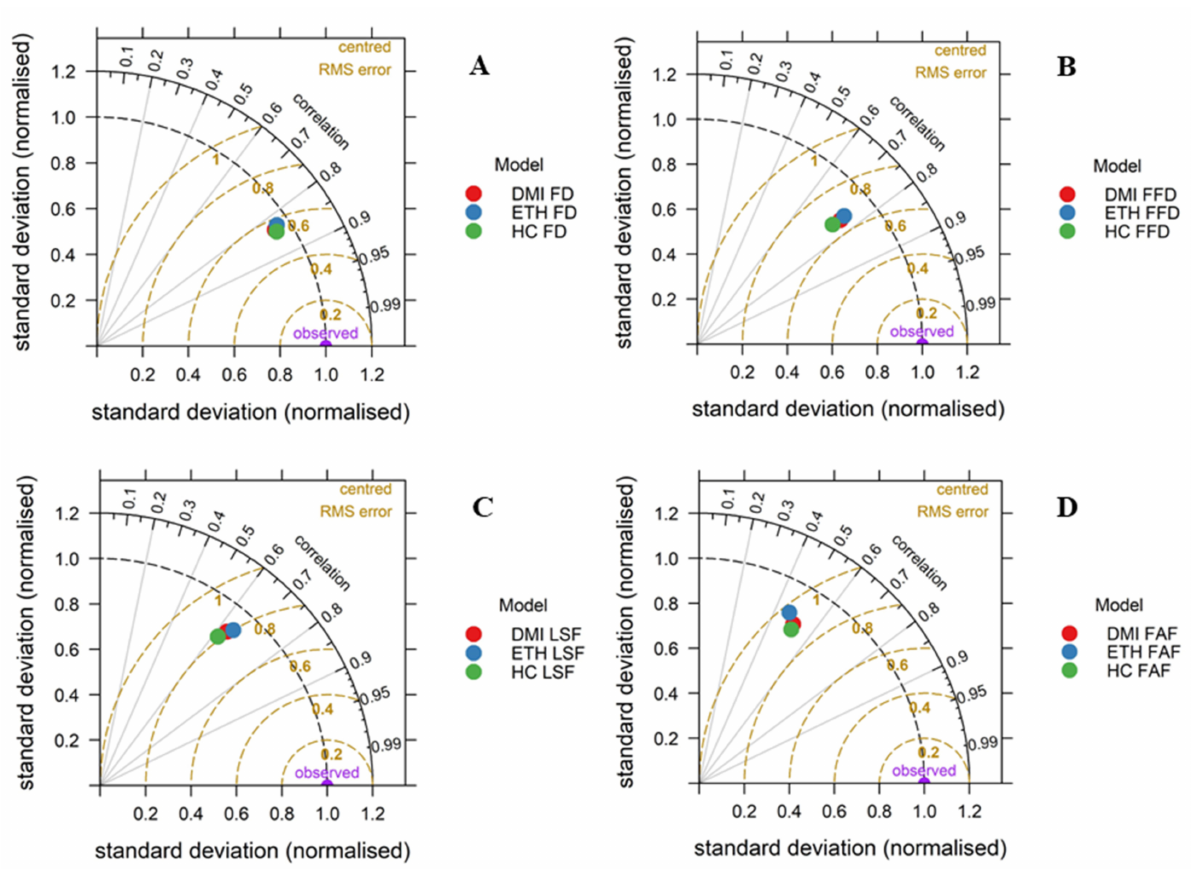
Figure 3. Models’ performance by Taylor diagrams for Frost Days ( A ), Free of Frost Days period ( B ), Last Spring Frost ( C ) and First Autumn Frost ( D )